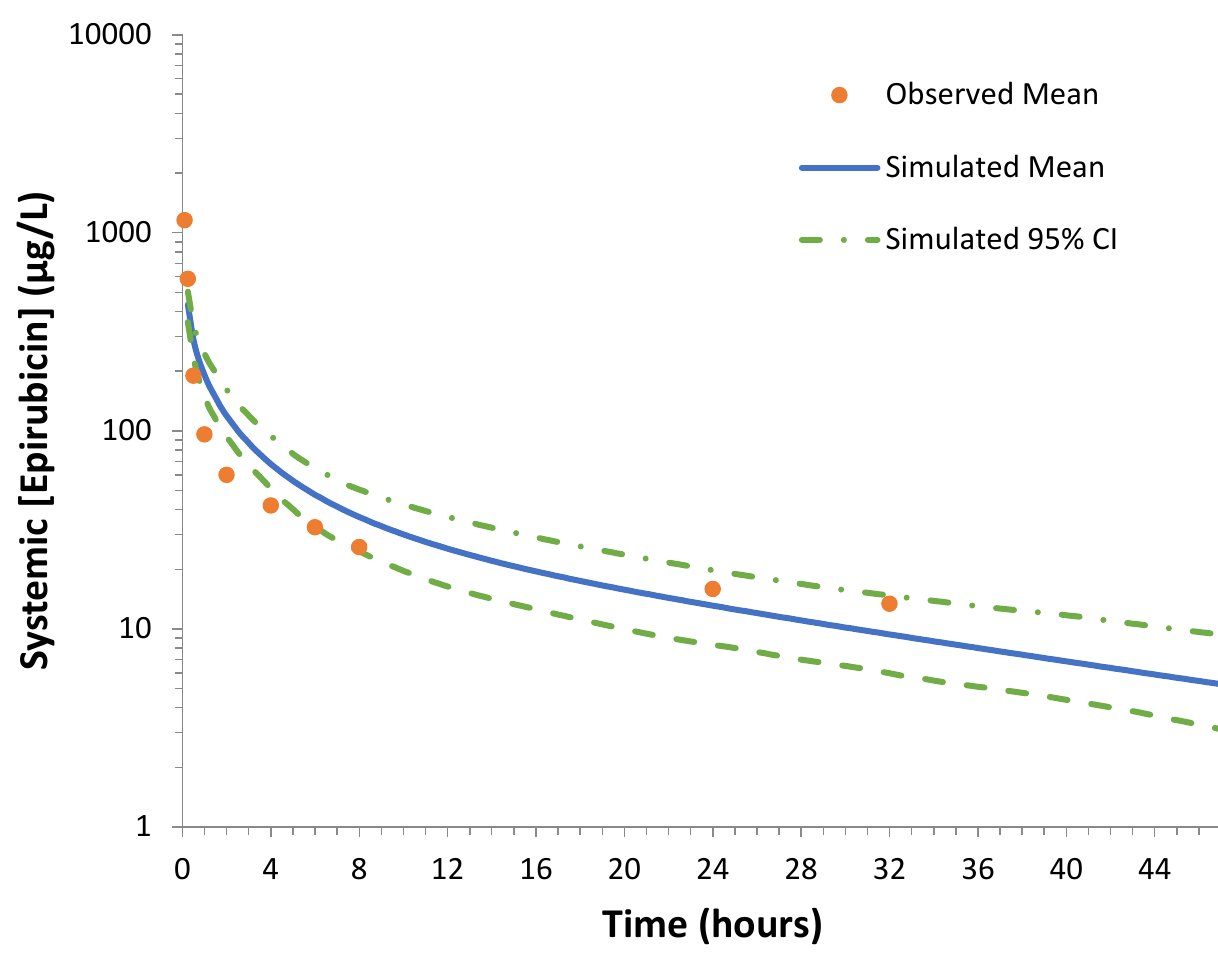
Figure 2. Representative overlay showing the simulated and observed epirubicin plasma concentra- tion time curves over 48 h following a single oral dose (50 mg/m 2 ). The solid blue line represents the mean simulated epirubicin plasma concentration, the dotted green lines represent the 95% confidence interval (CI) for the simulated data and the orange dots represent the mean observed data [34]. No data regarding variability in observed data was reported in the original publication.